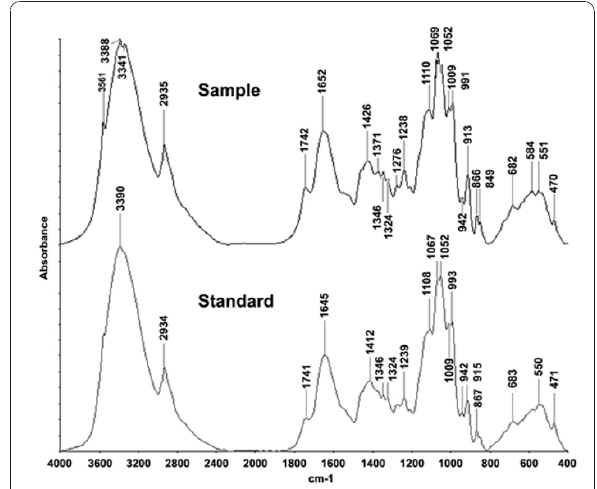
Figure 1 Spectrums of a RAS sample and the RAS standard . The wavelengths are shown on the x axis and the values of absorbance are shown on the Y axis. The wavelengths for the identified peaks are